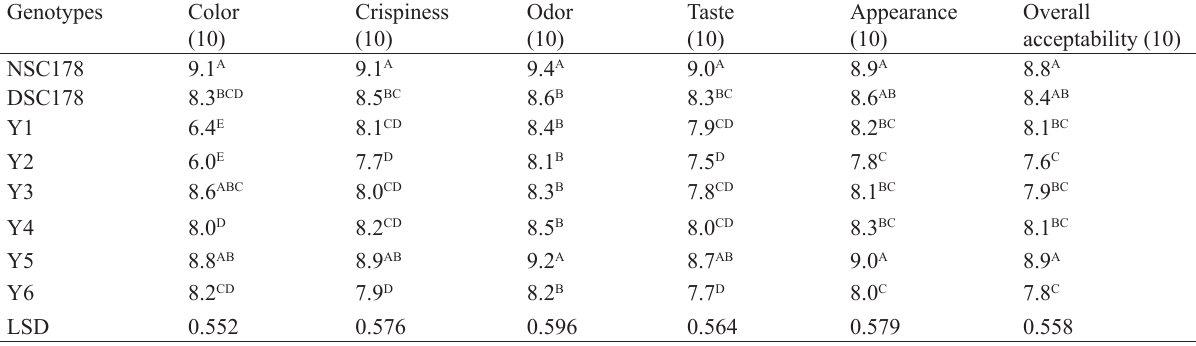
Table 4 Sensory characteristics of snacks from drought-tolerant corn genotypes